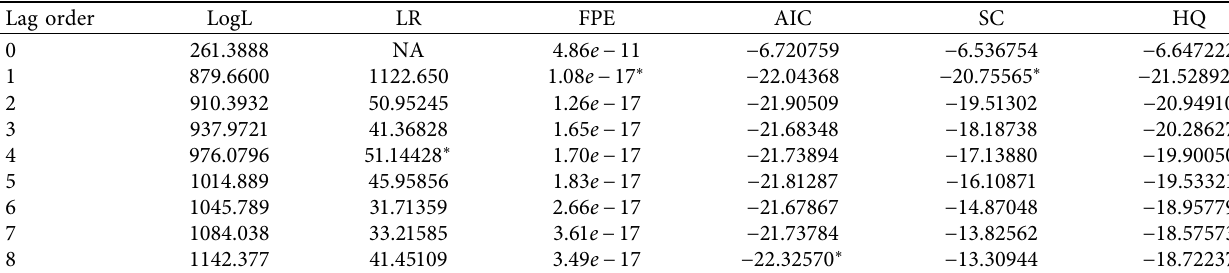
Table 3: Optimal lag order.